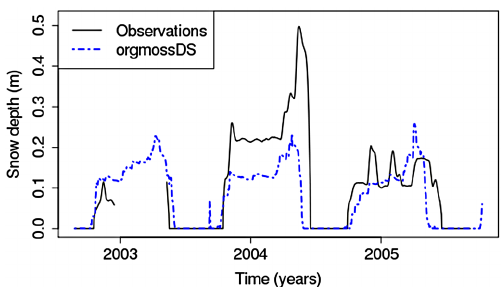
Figure 7. Simulated and observed snow depth at Samoylov over the same years as soil temperatures (Fig. 6b). The simulation orgmossDS includes all model improvements (see Table